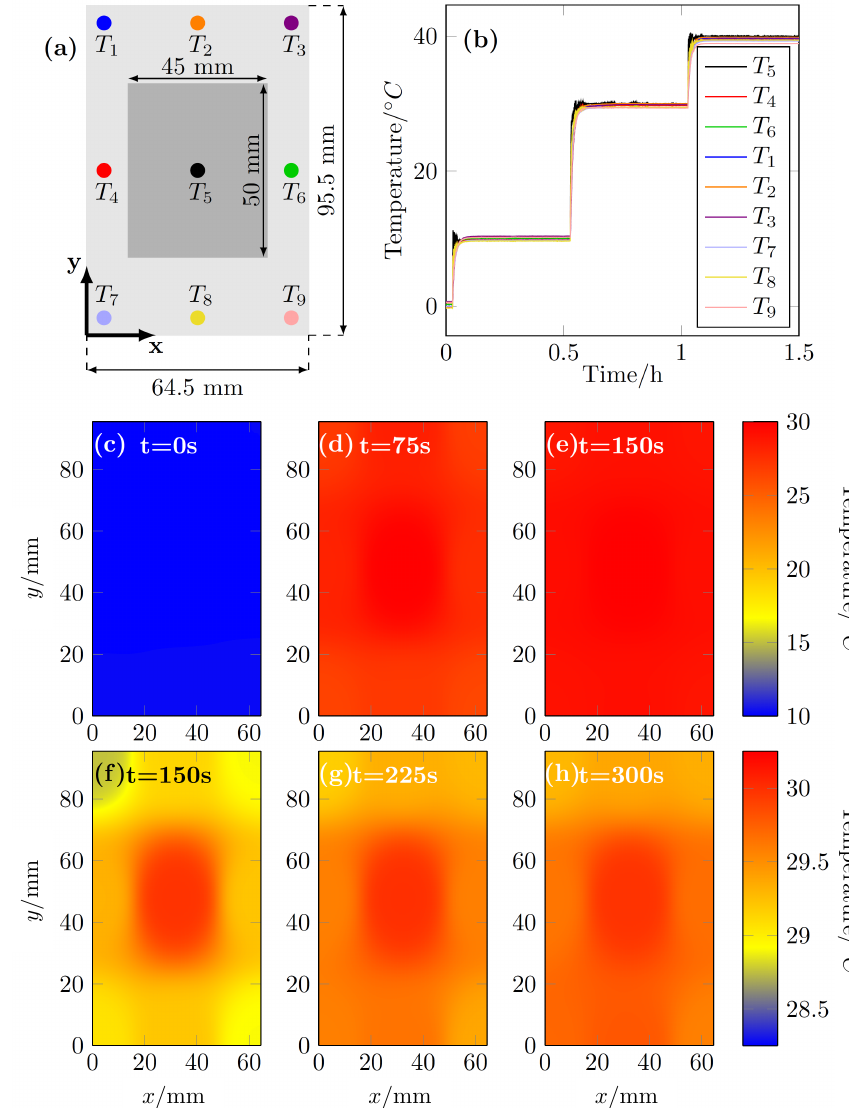
Figure 3. Investigation of the temperature homogeneity and the heating rate of the aluminum plate with the position of the Pt100 sensors and the PE (gray box) in ( a ), the time curve of the Pt100 sensors with an exemplary regulation from T = 10 ◦ C to T = 30 ◦ C and further to T = 40 ◦ C ( b ), the